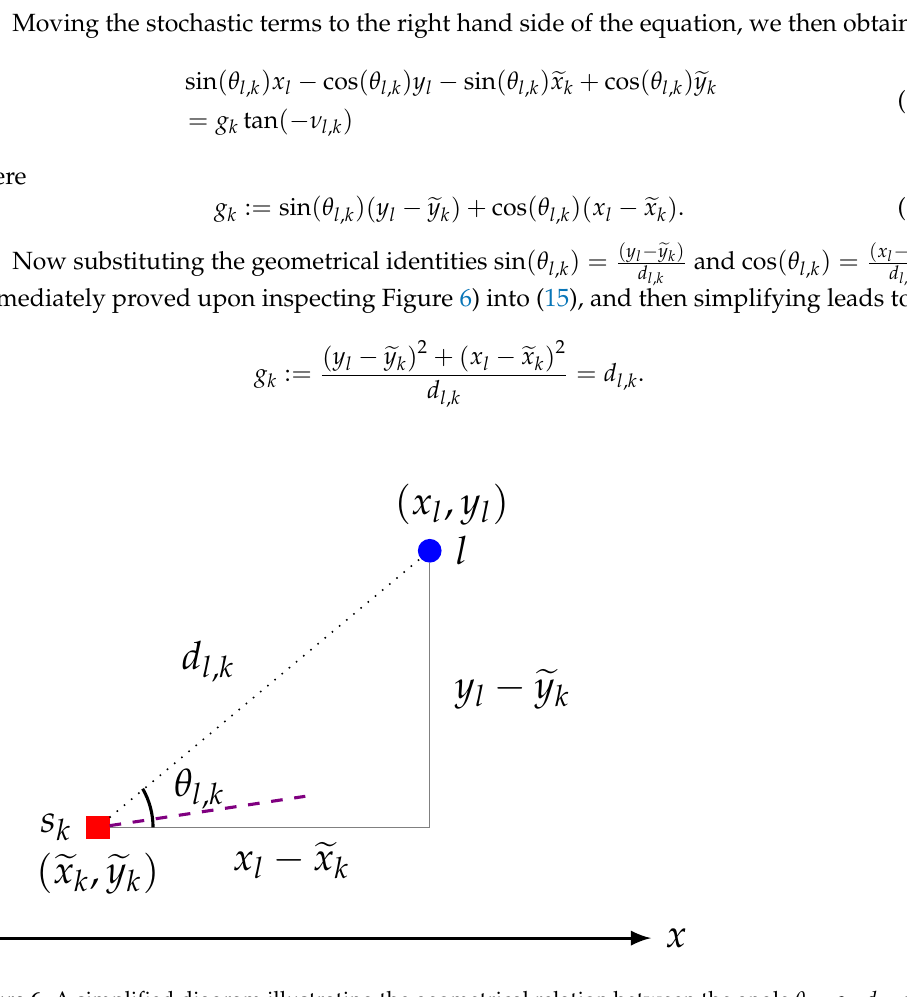
, s , d and l , k k l , k